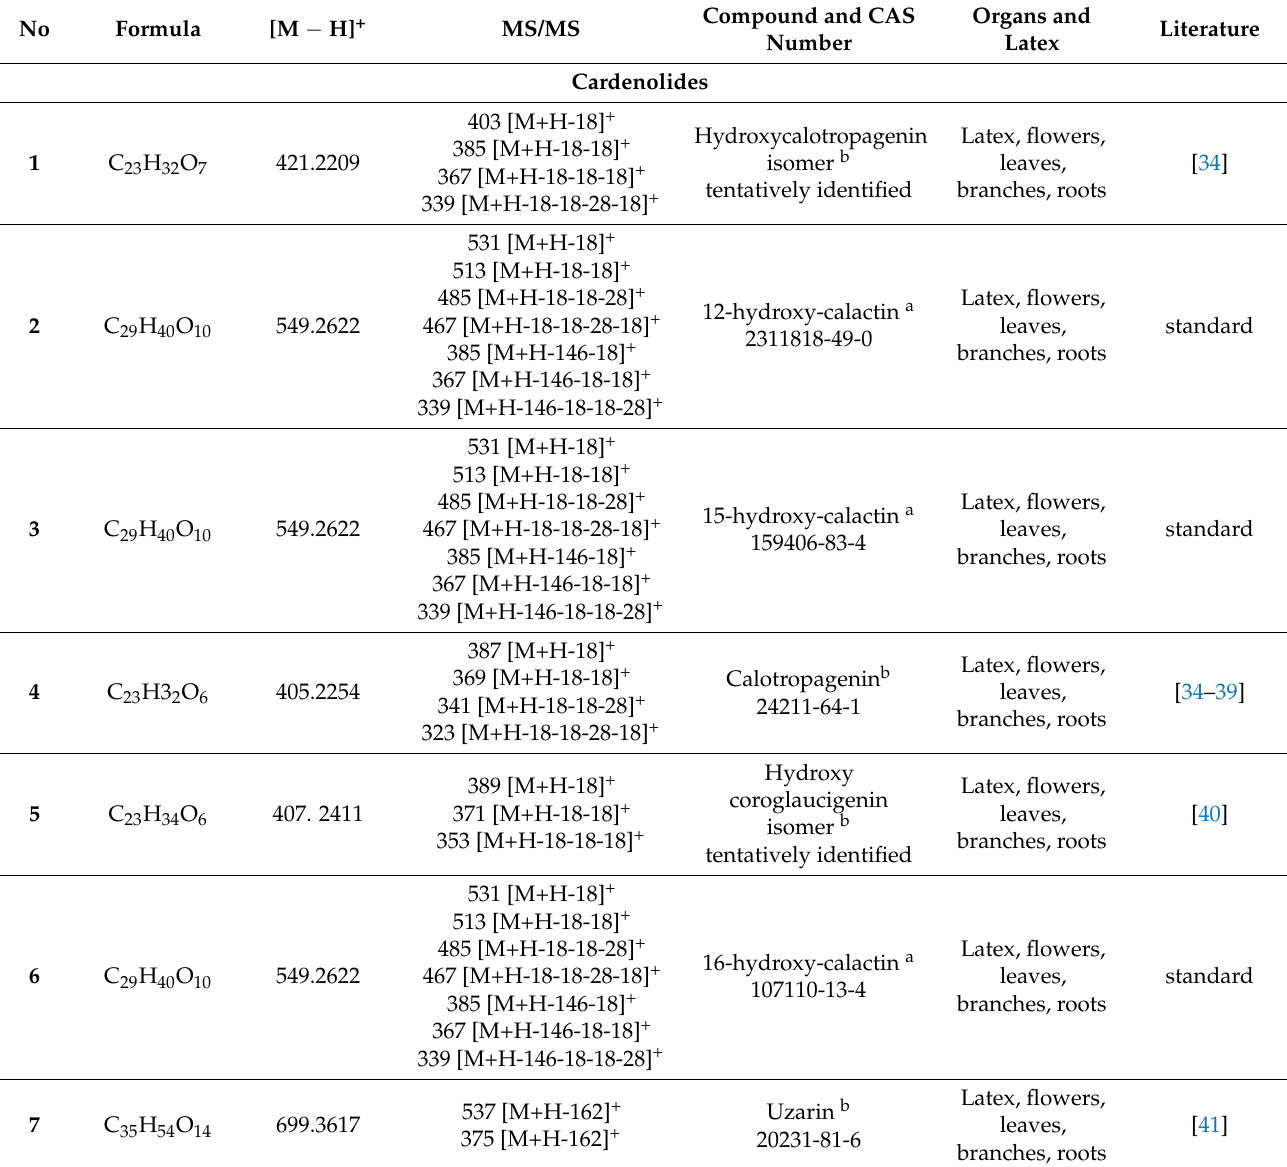
Table 1. MS Data of Compounds 1 – 37 detected in leaves, latex, flowers, branches and roots extract of C. procera